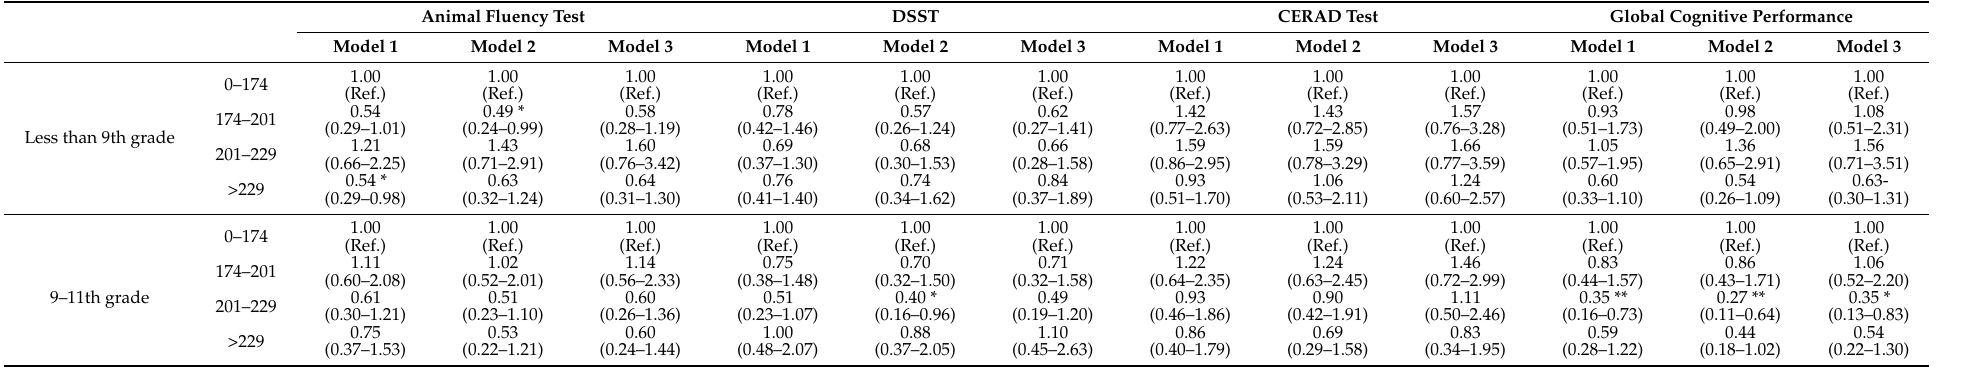
Table 6. Odds ratios (95% confidence intervals) for four dimensions of cognitive performance across quartiles of total cholesterol in different education sub-groups among female